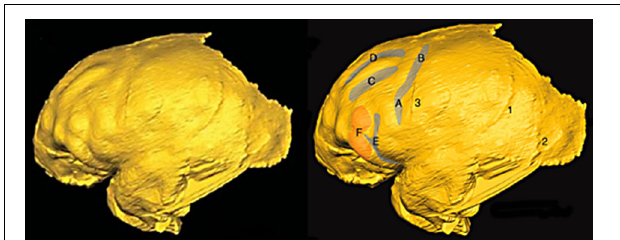
FIGURE 6 | Left lateral view of virtual endocast of MH1. Image on right shows Carlson et al.’s identifications: (A) pci , (B) pcs , (C) fi , (D) fs , (E) fo , (F) anterior inferior frontal gyrus, (1) and (2) meningeal arteries, (3) coronal suture. See legend to Figure 4 for key to abbreviations of sulci. Images reproduced from Carlson et al. (2011). Reprinted with permission from